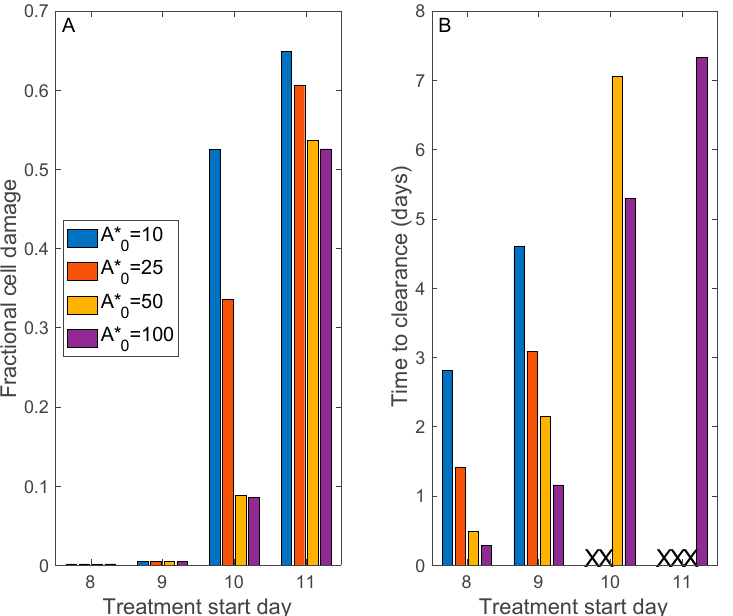
Figure 7. Model simulations to assess the effectiveness of convalescent plasma therapy. A range of donor plasma antibody titers (A* 0 ) and treatment delay (after initial viral exposure) are considered. Panel ( A ), maximum fractional cell damage; Panel ( B ), number of days after initiation of therapy to viral clearance. ‘X’ denotes no clearance. If treatment begins sufficiently early, all A* 0 values considered yield viral clearance and essentially no tissue damage was found. Otherwise, a sufficiently high donor plasma antibody titer would be required to clear the infection. Severe tissue damage may not be avoided if treatment begins more than 10 days after viral exposure.